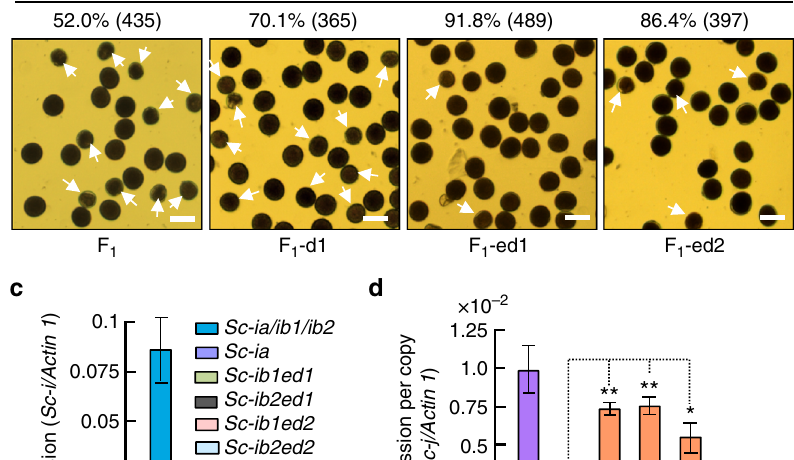
Table 2 Sc genotypic segregation in the edited F 2 families